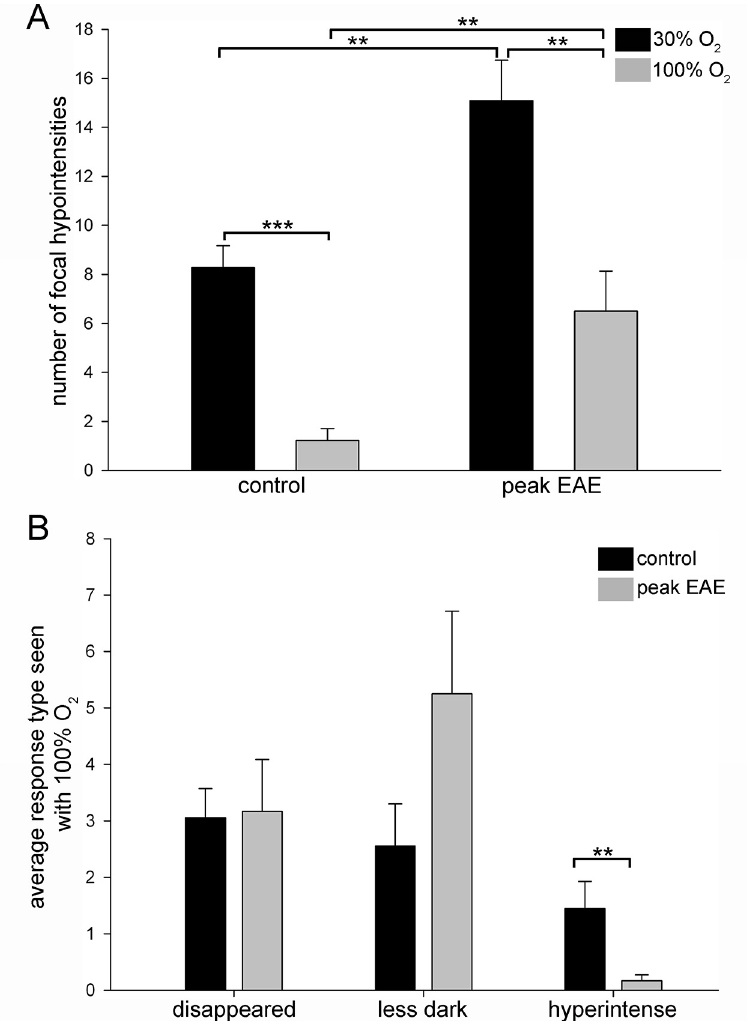
Fig 3. Quantitative assessment of responses of SWI hypointensities to hyperoxygenation. (A) The number of hypointensities seen before and after hyperoxygenation. Most hypointensities change with hyperoxygenation in both na ï ve controls and peak EAE mice. (B) Average response type seen with 100% O 2 , namely hypointensities disappearing, hypointensities becoming less dark but not disappearing completely and hypointensities becoming hyperintense. The number of hypointensities that became hyperintense upon administration of 100% O 2 was significantly greater in na ï ve control mice than in peak EAE mice. ** p < 0.01 and *** p < 0.001 by paired t -test in (A), ** p < 0.01 by Mann-Whitney U test in (B). naïve controls (1.4 ± 0.5) and peak EAE mice (0.2 ± 0.1) ( p = 0.006, Mann Whitney U-test)